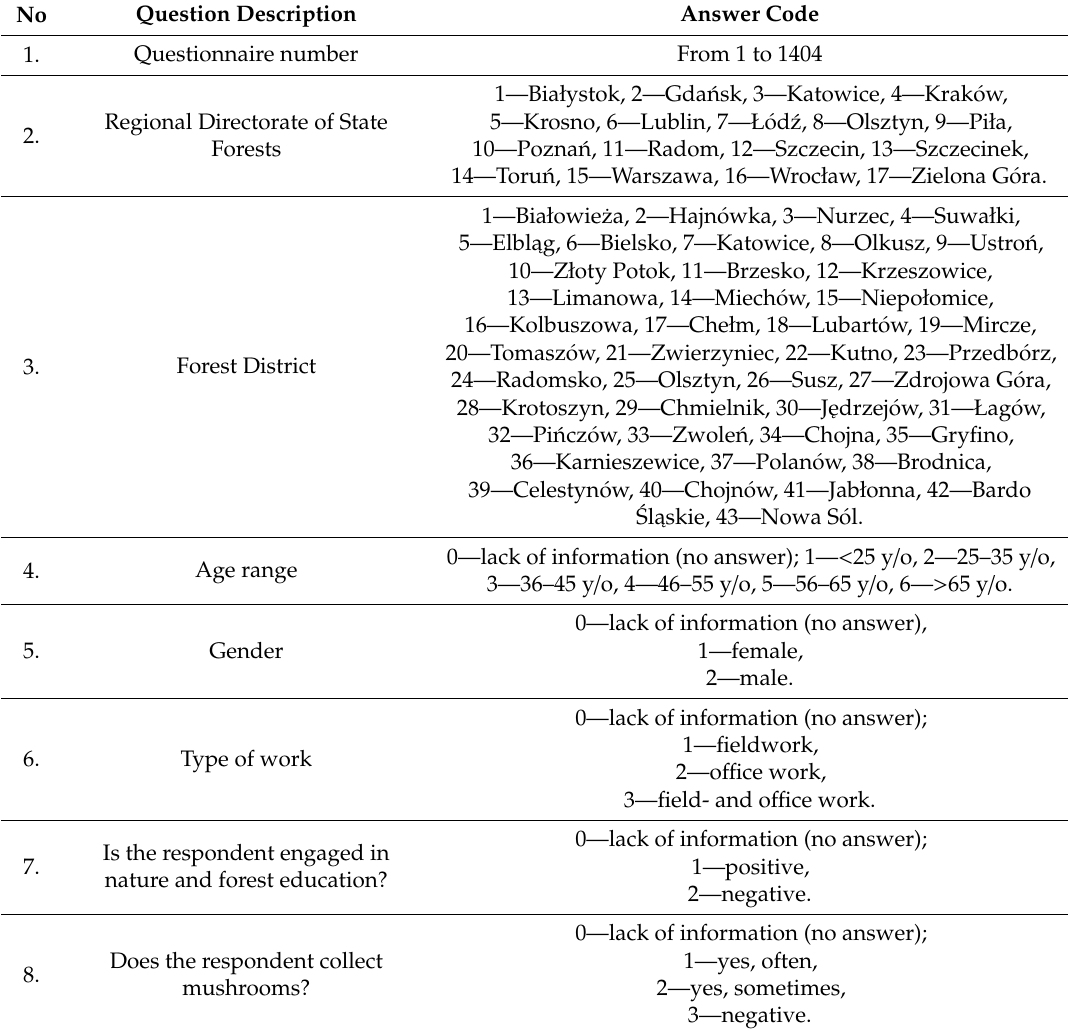
Table A1. Data codification for statistical